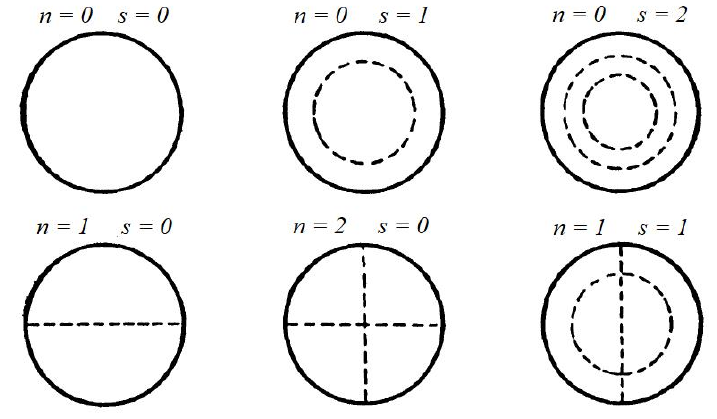
Figure 21. Nodal circles and nodal diameters. Table 10. Some values of α i for some free vibration